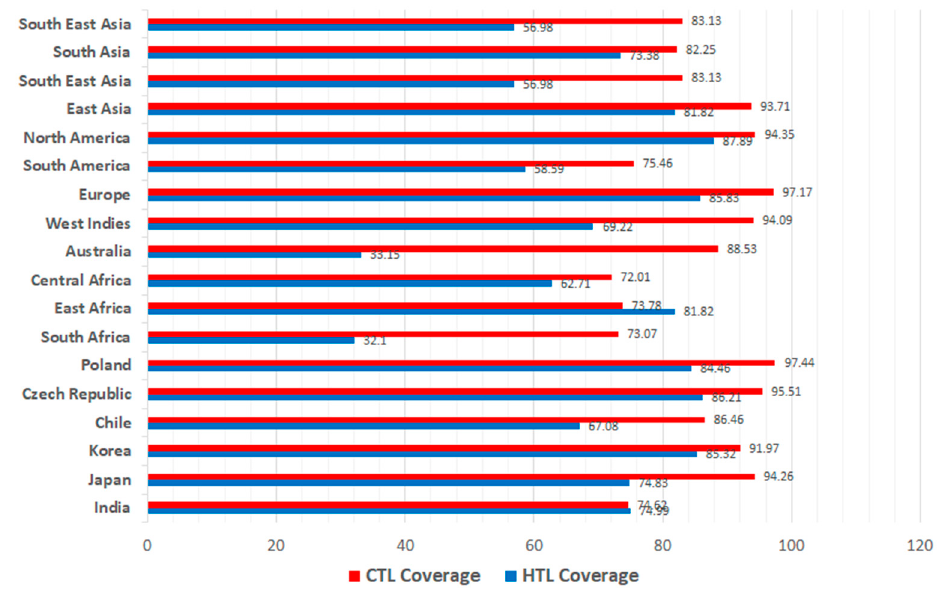
Figure 1. Population coverage of CTL and HTL epitopes with respect to different geographic regions. Table 4. List of B-cell epitopes selected for design of vaccine construct.